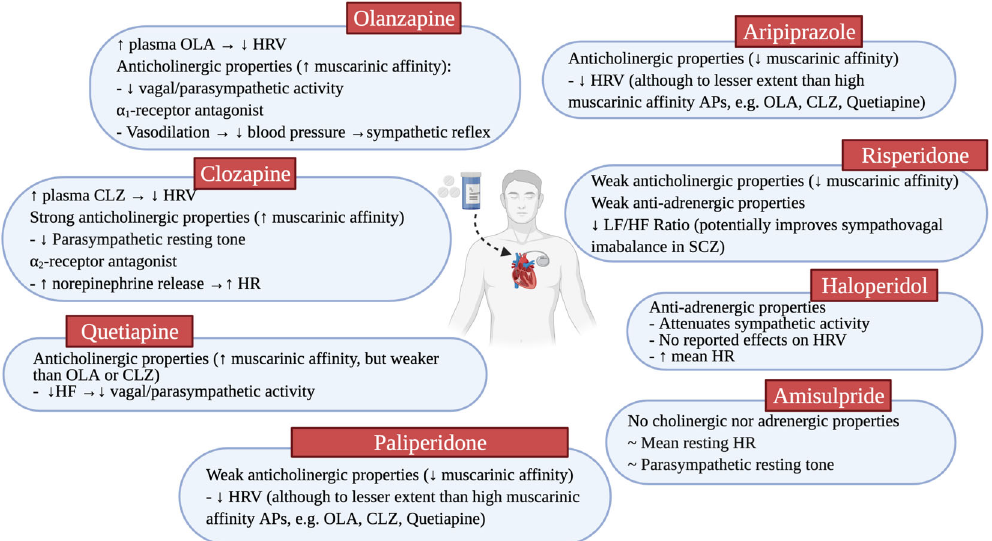
Fig. 2 Antipsychotic properties and their effects on autonomic functioning and heart rate variability. The differing effects of antipsychotics (AP) on autonomic dysfunction and heart rate variability (HRV) may be dependent on the pharmacokinetic properties of the APs (i.e. their af fi nities for cholinergic and adrenergic receptors).